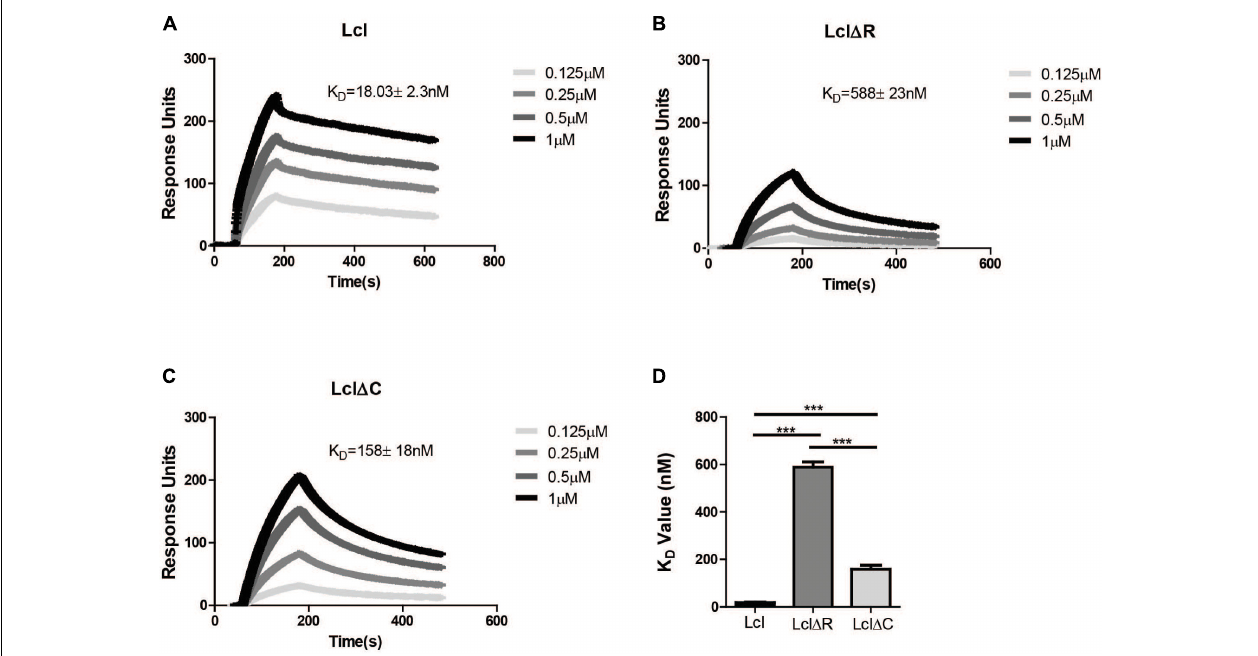
FIGURE 2 | Both the R domain and C domain of Lcl are required for optimal binding to fucoidan. (A–C) Surface plasmon resonance sensorgrams of immobilized His-tagged purified Lcl (A) , His-tagged Lcl (cid:49) R (B) , and His-tagged Lcl (cid:49) C (C) to the indicated concentrations of fucoidan. (D) Bar graph of the dissociation constants of Lcl, Lcl (cid:49) R and Lcl (cid:49) C to fucoidan. The values plotted are the average of three individual experiments, ∗∗∗ denotes p < 0.001 by one-way